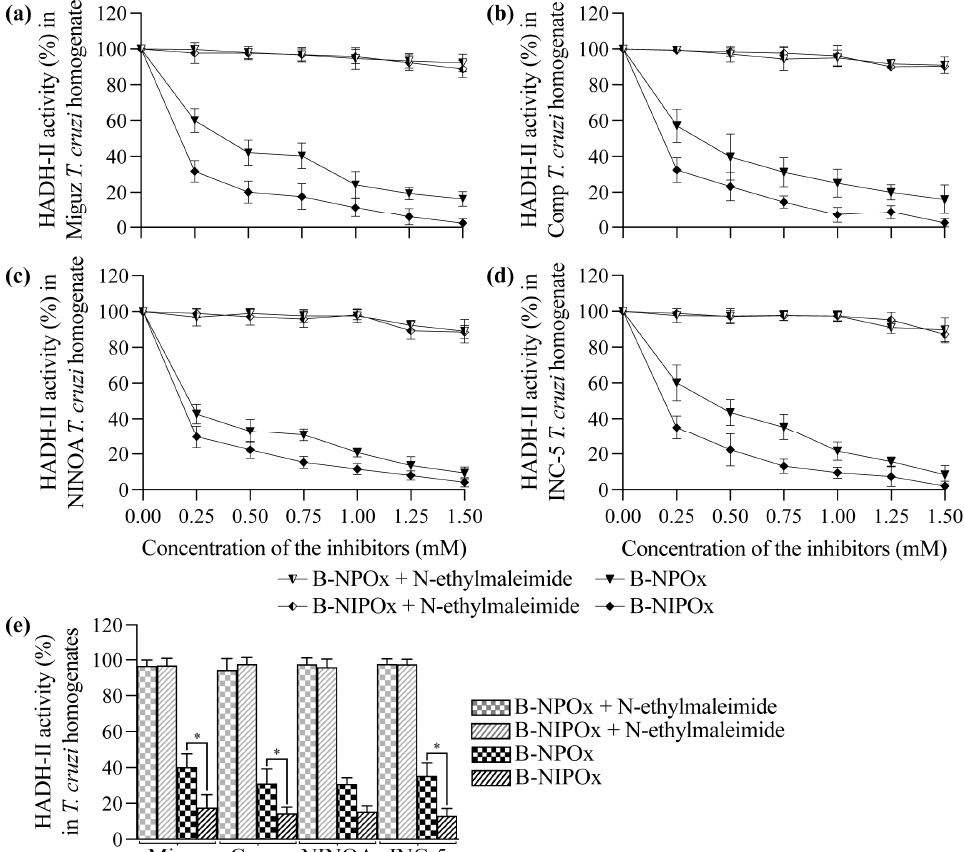
Figure 2. The benzyl ester of N-isopropyl oxamic acid (B-NIPOx) has a better inhibitory effect on the α -hydroxy acid dehydrogenase isozyme II (HADH-II) than the benzyl ester of N-propyl oxamic acid (B-NPOx) in Trypanosoma cruzi homogenates. The inhibitory activity of B-NPOx and B-NIPOx over the HADH-II was analyzed with or without 1 mM N-ethylmaleimide in homogenates of ( a ) Miguz, ( b ) Compostela (Comp), ( c ) NINOA or ( d ) INC-5 T. cruzi strains, and in the presence of 0.12 mM NADH + + H + and 5 mM α -ketoisocaproate. The inhibitors were evaluated at concentrations of 0.25, 0.50, 0.75, 1.00, 1.25 and 1.50 mM. The HADH-II activity was measured by the changes in the absorption at 340 nm over 5 min and was expressed as a percentage of Δ E 340 nm/min, where the enzymatic activity in absence of inhibitor was considered 100%. ( e ) Asterisks represent statistically significant differences between the HADH-II activity in the presence of 0.75 mM inhibitors (* p ≤ 0.05). n = 6. One experiment representative of three is shown.